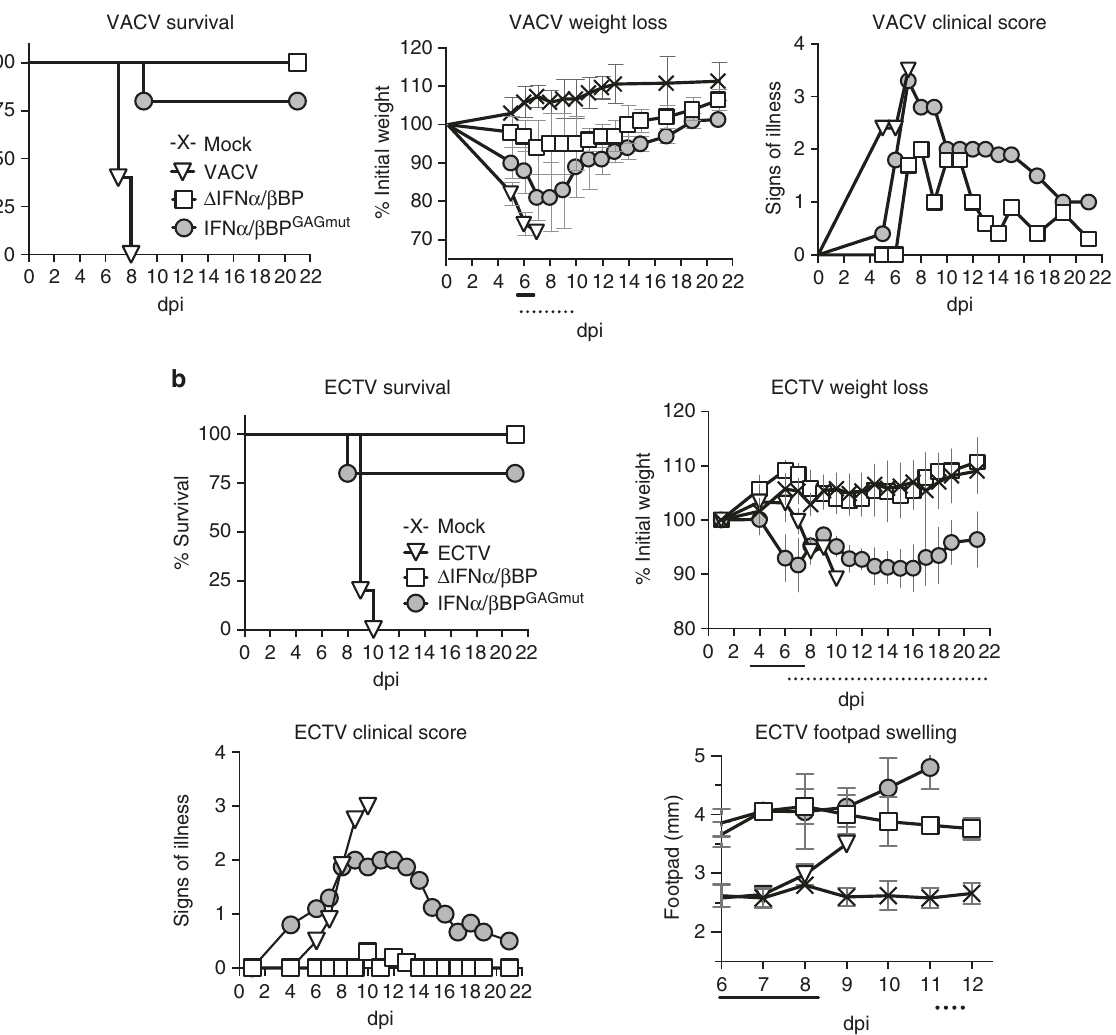
Fig. 4 The IFN α / β BP cell surface binding activity contributes to poxvirus pathogenesis. Balb/c mice ( n = 5) were infected i.n. or s.c. in the footpad with the indicated VACV (10 5 pfu) ( a ) or ECTV (10 pfu of WT and 10 6 pfu of the IFN α / β BP mutants) ( b ), respectively. Mice were monitored daily for survival, bodyweight and signs of illness, and footpad swelling in the case of ECTV. Weight data are expressed as the mean ±SD of the fi ve animals weights compared to their original weight at the day of inoculation. Signs of illness, as a score ranging from 1 to 4, and the size of the footpad (mm) where inoculation was performed are also expressed as the mean of the fi ve animals. Statistical analyses performed were multiple t -tests with FDR Q = 1% and days at which signi fi cant differences ( p < 0.05) were found between IFN α / β BP GAGmut and WT or Δ IFN α / β BP infections are indicated with solid or dotted lines, respectively. One representative experiment of two is